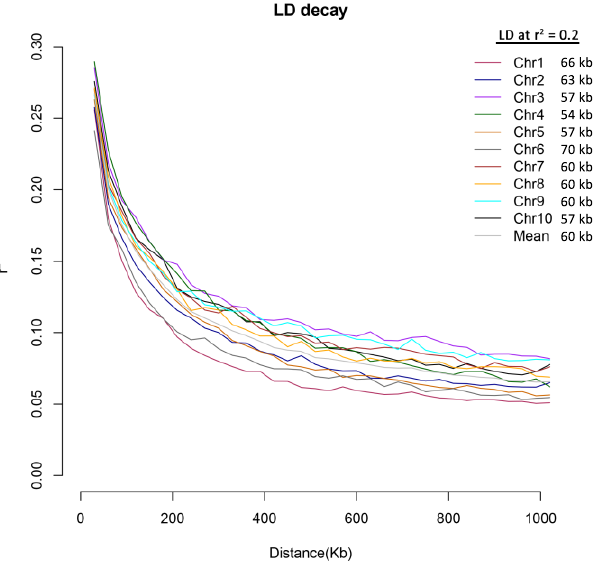
Figure 1. Genetic structure of 213 lines of field maize and waxy maize. ( A ) Appearance of kernel structures that was used as a criterion to assign maize lines as field maize (non-waxy) and waxy maize. ( B ) Two-dimensional plot of principal components (PC1 vs. PC2), ( C ) phylogenetic tree, and ( D ) STRUCTURE based on 17,467 SNP markers. The field maize and sweet maize accessions in ( B ) are shown in blue and green, respectively. The two different subpopulations in ( C , D ) are shown in green and red.